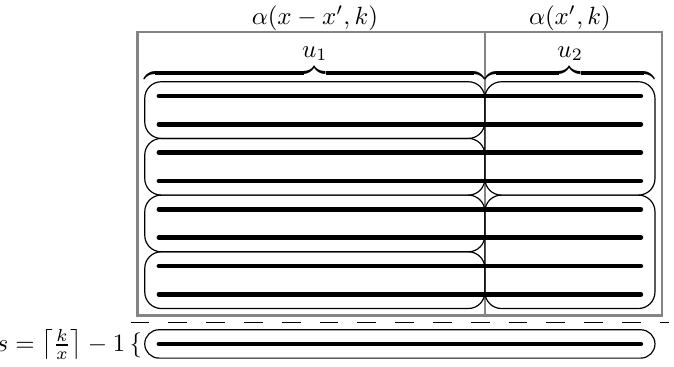
Figure 4: Graphical representation of the output of Algorithm α ( x, k ) if the first call is a reduction call (Case 3) and the second call is a composition call (Case 4) for which both recursive subcalls are